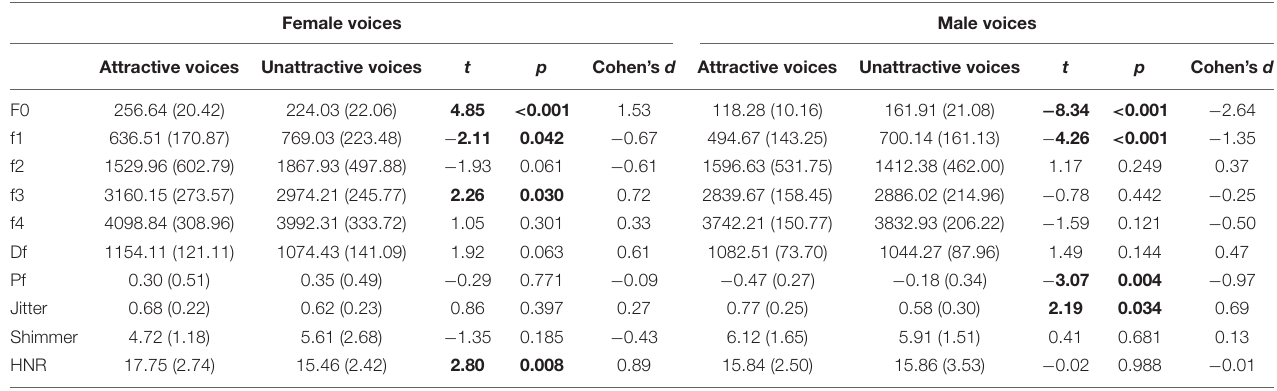
TABLE 2 | Acoustic differences between attractive and unattractive voices.